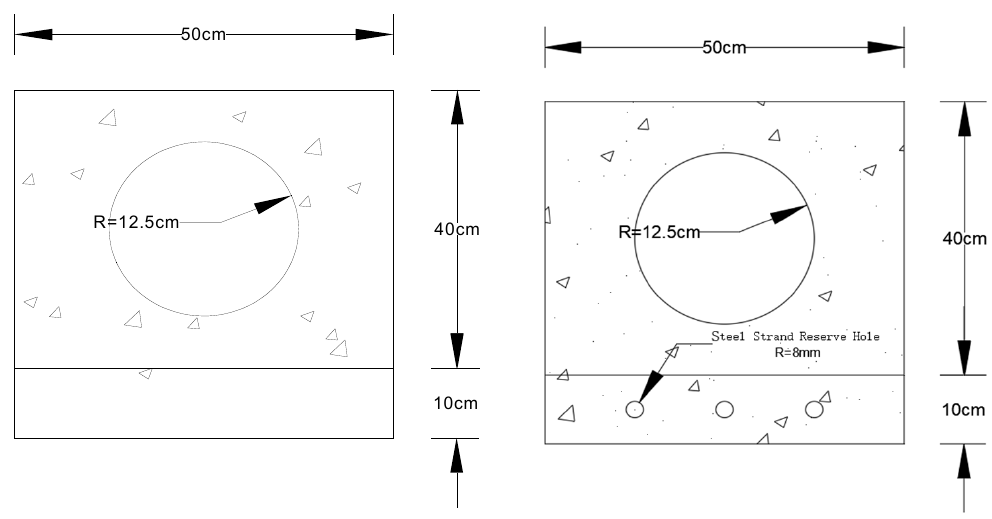
Figure 3. Cross section of the test beam.